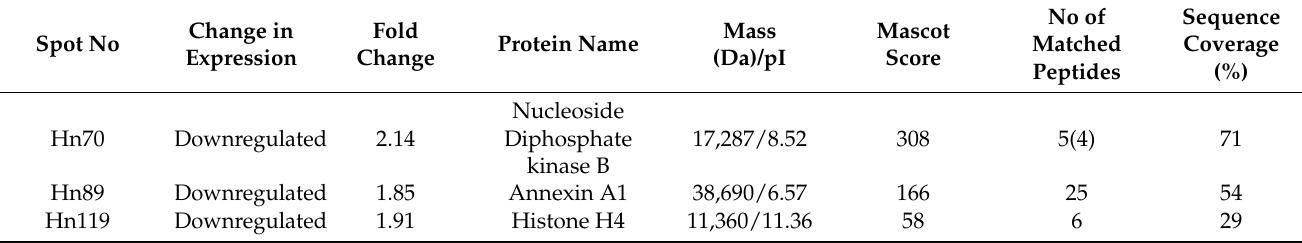
Table 4. Protein spots that underwent significant changes in expression after treatment with NH3 alone in HT-29 cell line and their identification (name, mass, Da/pI, mascot score, matched peptides, percentage of sequence coverage).